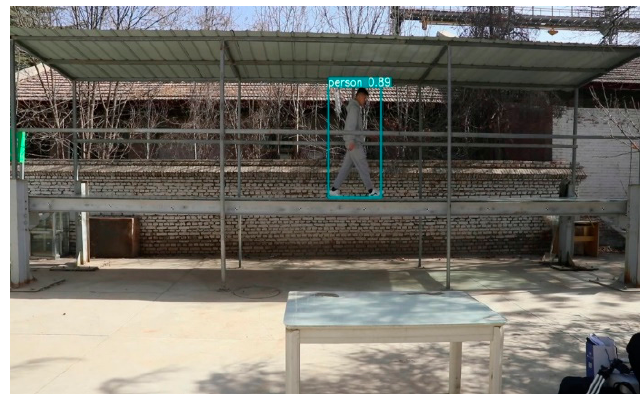
Figure 8. Pedestrian detection result graph.